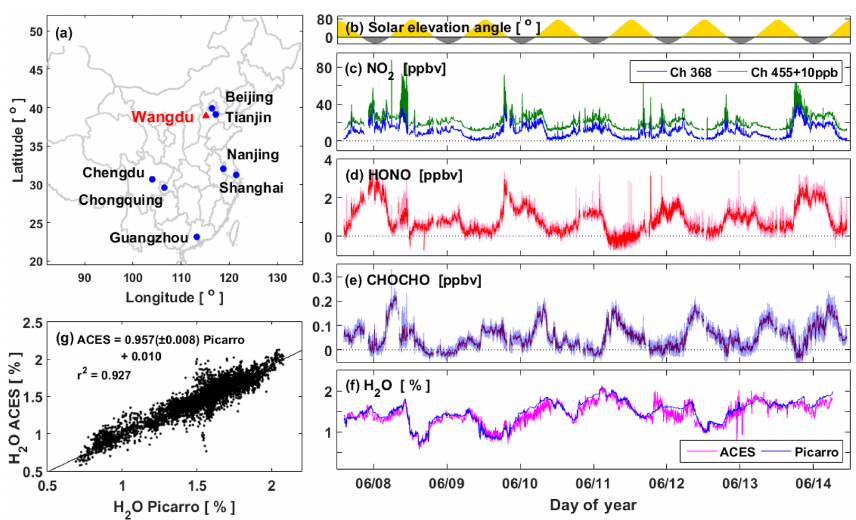
Figure 12. Data from the CARE Beijing-NCP 2014 ground site. (a) Map of region, showing ground site relative to major cities in China. Time series of (b) solar elevation angle, (c) NO 2 , (d) HONO, (e) CHOCHO, and (f) H 2 O. NO 2 measured by Ch 455 is offset by 10ppbv for clarity. (g) Correlation plot for H 2 O measured by ACES and a Picarro instrument. The slope is 0.957 ± 0.008 with r 2 =